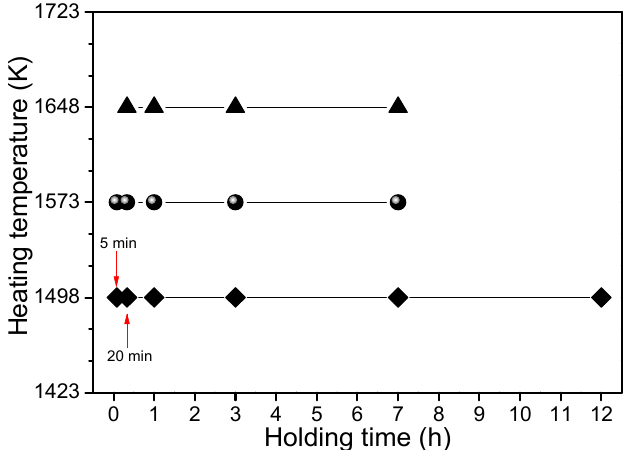
Figure 2. Heating experiments of steel under three temperature conditions.